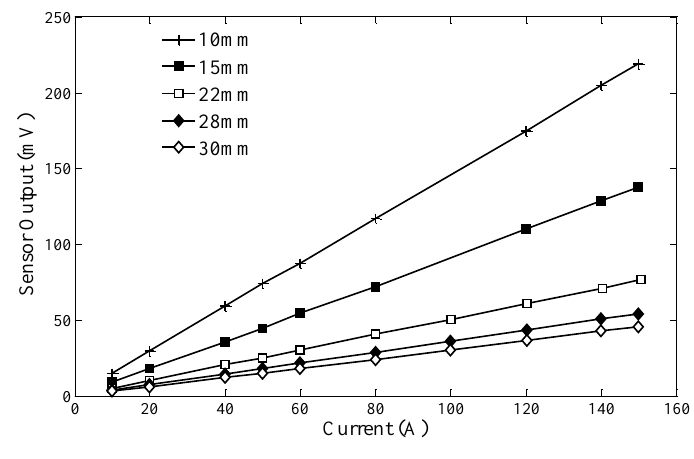
Figure 13. Experimental sensor output voltage for various